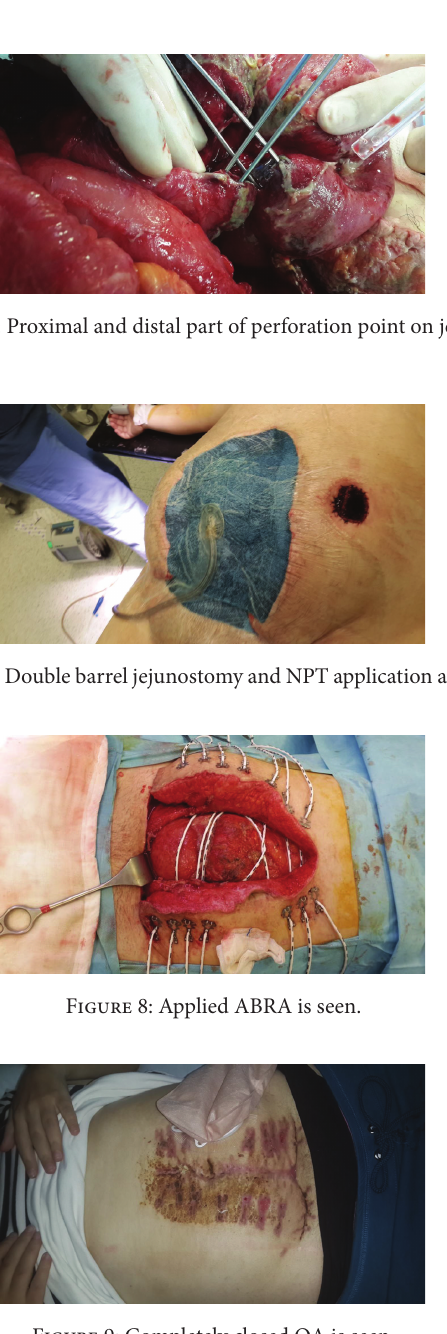
Figure 9: Completely closed OA is